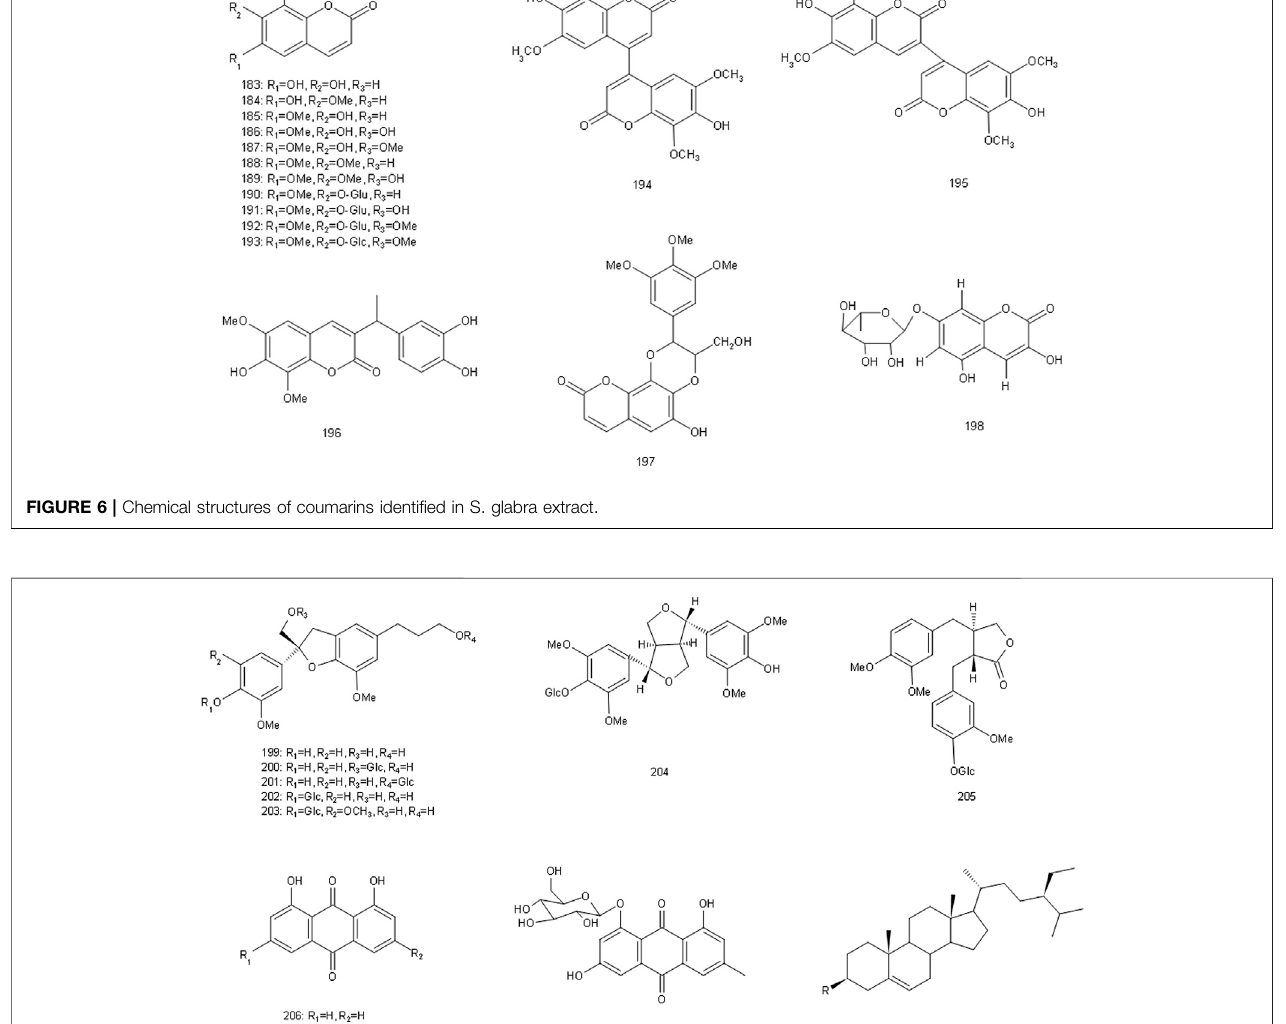
Frontiers in Pharmacology |